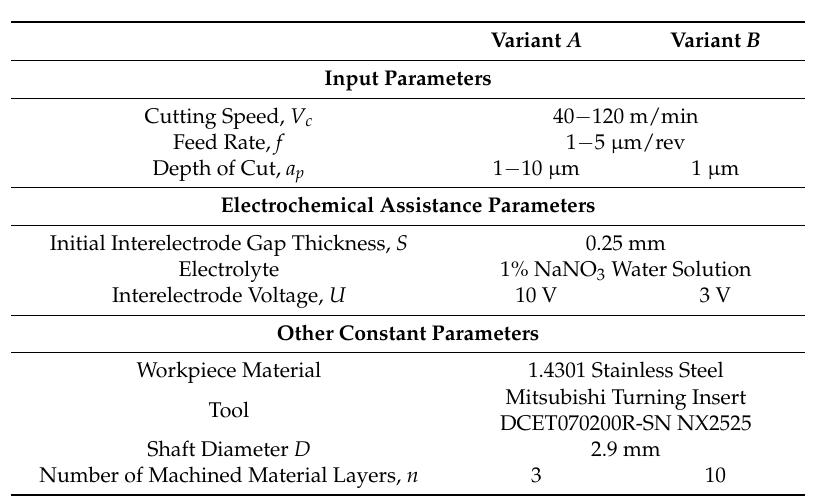
Table 1. Input and constant machining parameters used during experiments of electrochemically assisted microturning in variants A and B